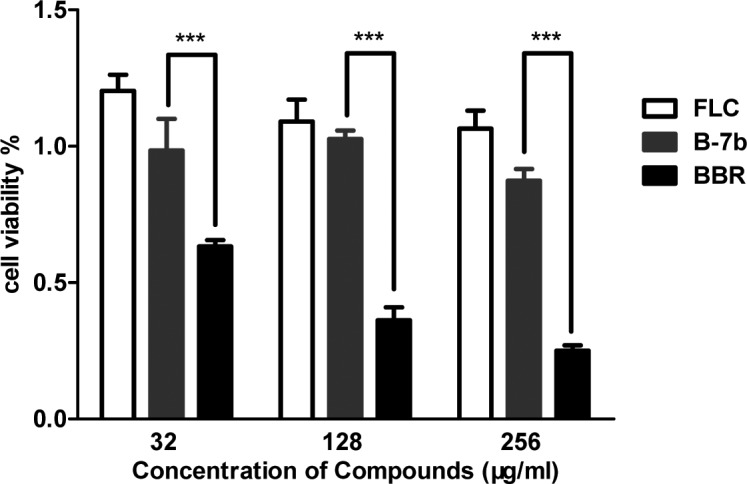
The in vitro cytotoxicity evaluation of B-7b using XTT assay.The cytotoxic effect of B-7b towards HUVEC viability was assessed by an XTT test following a 4-h treatment, when compared to that of FLC and BBR. ***, P<0.001 versus cells treated with BBR.